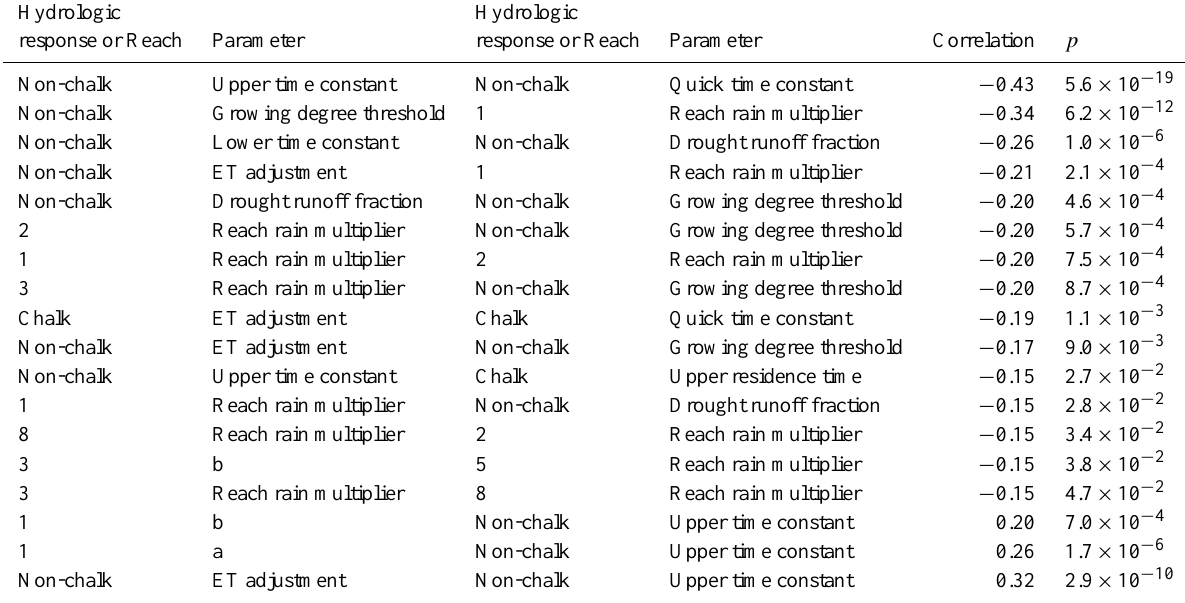
Table 7. Significant Pearson’s correlations between parameter values from ensemble of credible parameter